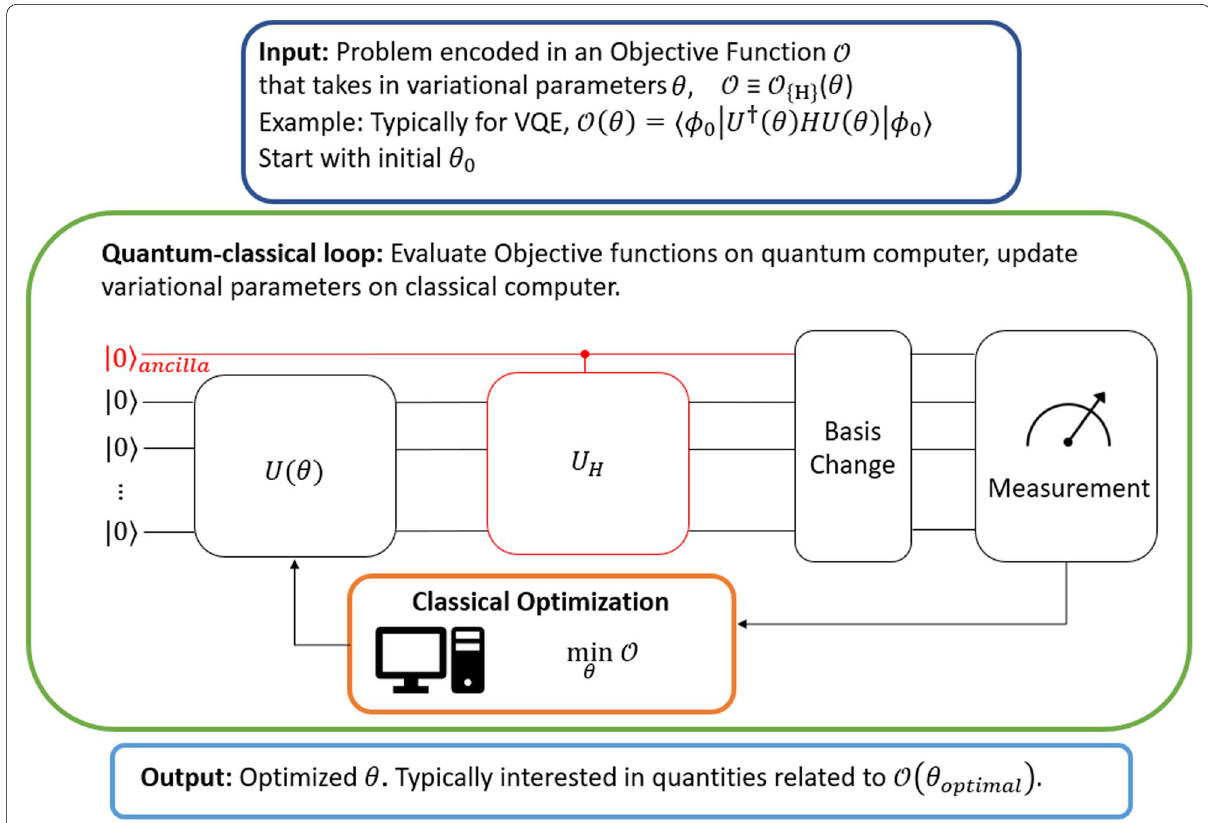
Fig. 3 Figure adapted from [15]. Diagrammatic representation of a typical VQA. In the input stage, we encode the problem in an objective function, and next choose a PQC/ansatz. The circuits are then measured. This is typically achieved with basis changes or the help of Hadamard tests (labelled in red in the diagram), depending on the objective function. A classical optimizer is used to update the parameters. This gives rise to the quantum-classical feedback loop. At the end, after the optimizer has found the optimal parameters to minimize the objective function, we read out the result to gain the desired